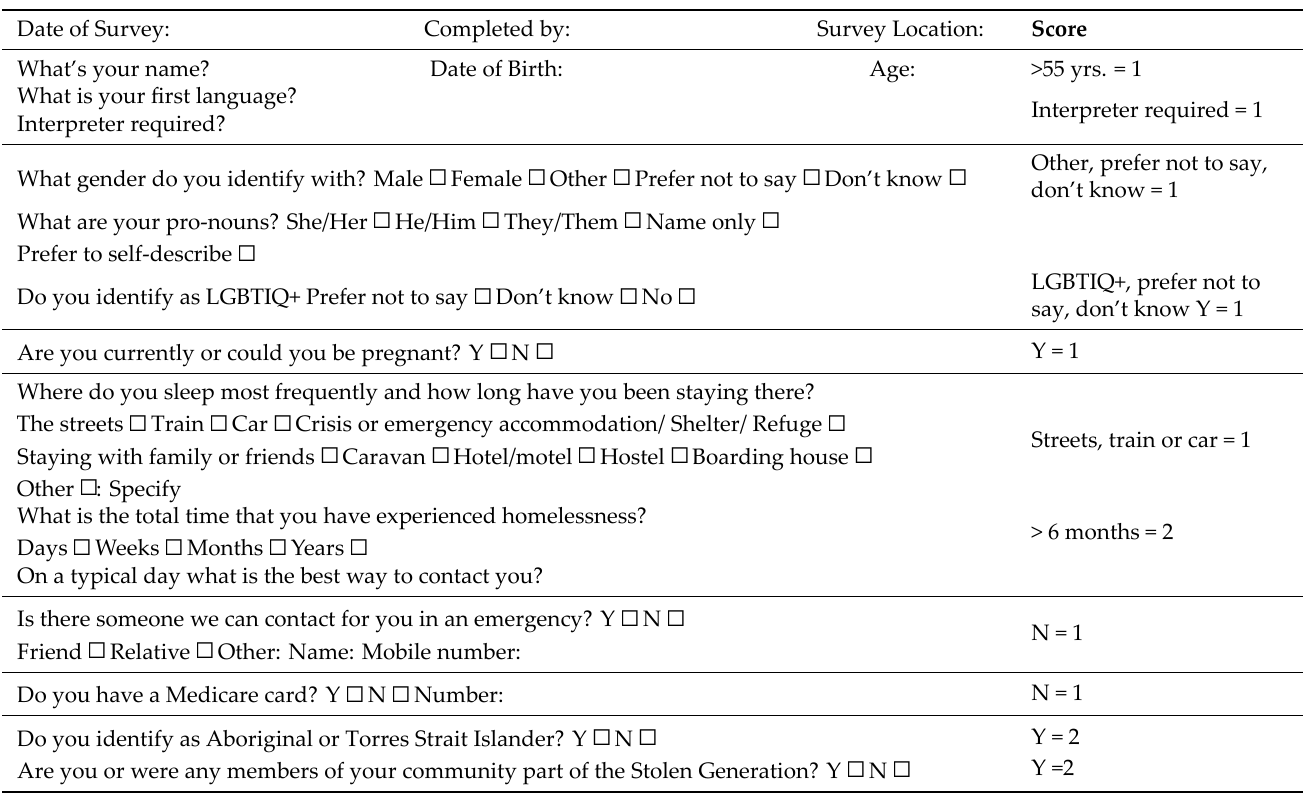
Table 1. Original HHACT Survey [15] Re‑use permitted under CC BY‑NC., 2022, Jane Currie, et